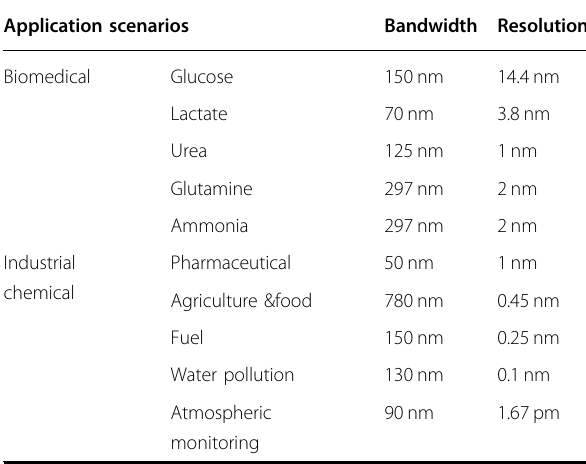
Table 1 Key performance metrics required for different spectral applications Application